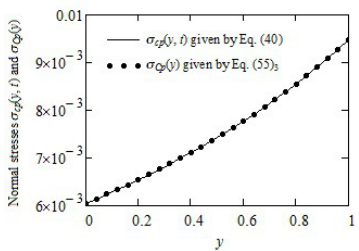
Figure 4. Comparison between the normal stresses σ cp ( y , t ) and σ Cp ( y ) for Re = 100, We = 0.3, α = 0.4, ω = 0.001 and t =